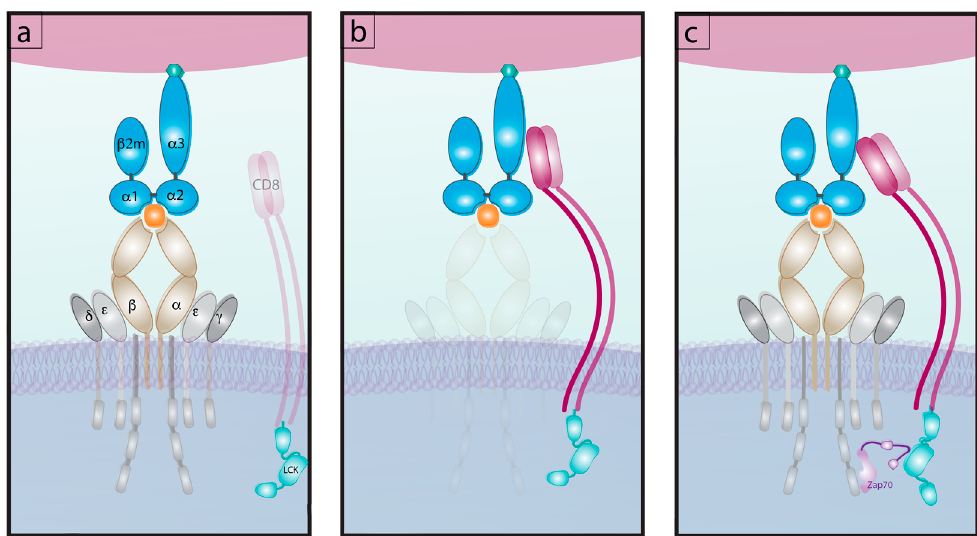
Figure 3. The interactions of pMHC with TCR and co-receptor. ( a ) TCR affinity interaction for pMHC excluding CD8 co-receptor. ( b ) CD8 Affinity interaction for pMHC excluding TCR. ( c ) The tri molecular interaction of TCR, CD8 and pMHC read out as “normalized adhesion bonds” and the engagement of Lck with Zap70.